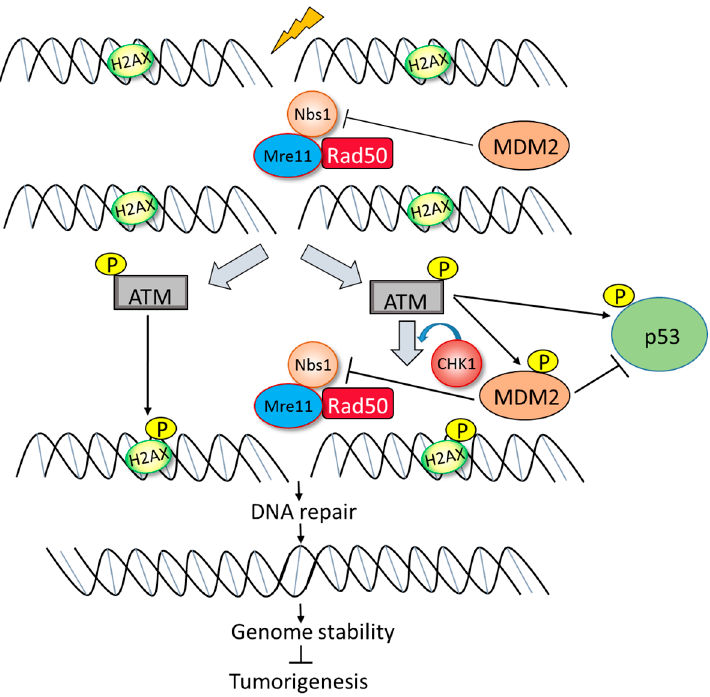
Figure 4. Model of inhibition of DNA break repair by Mdm2. Double-strand break induced by irradiation is detected by the M/R/N complex. ATM is recruited to the DNA-strand break and activated by auto-phosphorylation. In turn, activated ATM phosphorylates Nbs1, histone H2AX, p53, and Mdm2. MDM2 delays the early phosphorylation process, which is necessary for DNA double- strand break repair, causing inefficient DNA break repair and if not repaired could lead to genomic instability and tumorigenesis (Modified from Bouska and Eischen [56,84,93]). Inhibition = Activation =